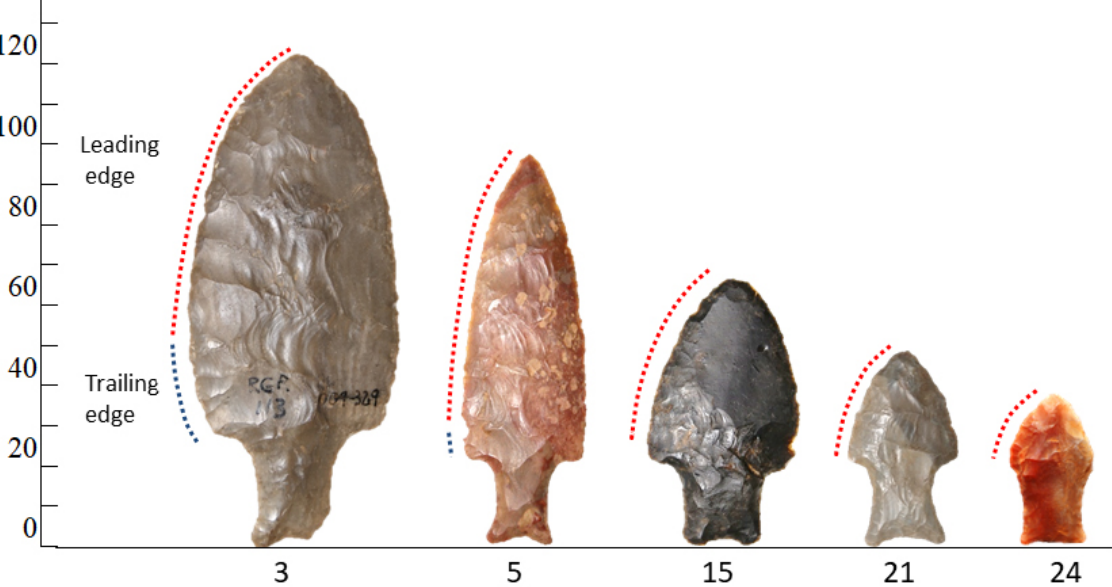
Figure 19. Changes in the relative length of the leading edges, keeping triangular blades and straight shoulders (except in the smaller point #24) throughout the rejuvenation process (or different and smaller designs; see